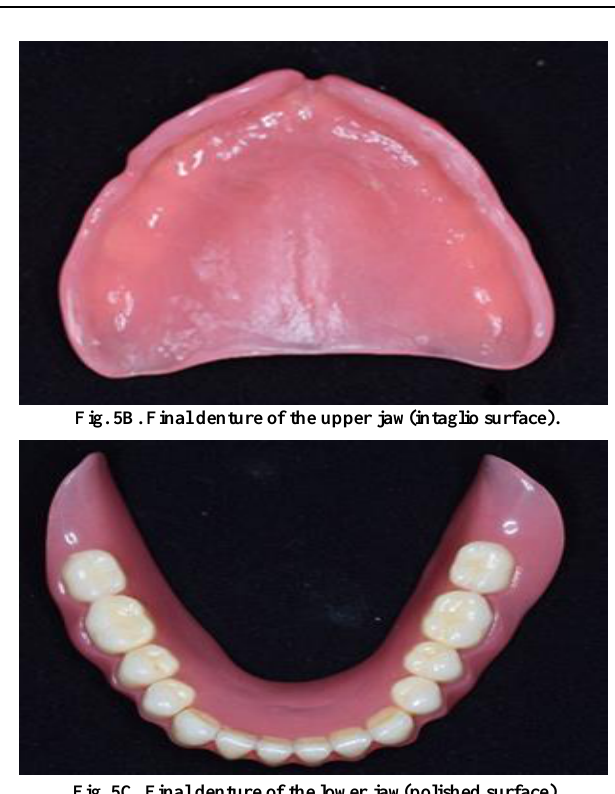
Fig. 5C. Final denture of the lower jaw(polished surface).